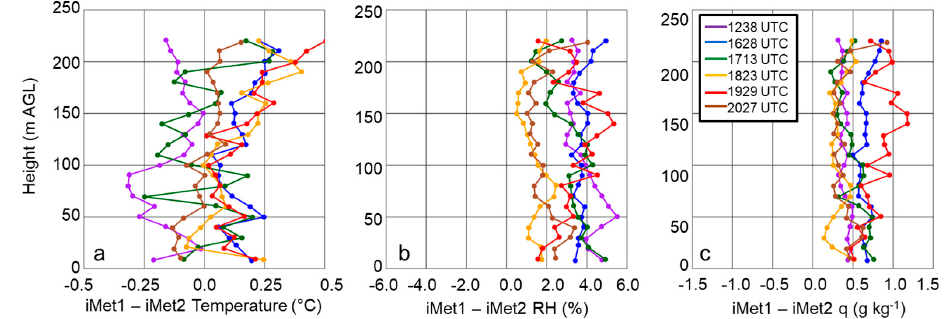
Figure 6. Difference between two iMet-XQ sensors; iMet-XQ 1 and iMet-XQ 2, in temperature ( a ), RH ( b ), and q ( c ) during six flights using a DJI S-1000 sUAS flown on 5 April 2017 at Cullman, AL. Purple, blue, green, orange, red, and brown correspond with flights made from 1238-1244 UTC, 1628-1639 UTC, 1713-1725 UTC, 1823-1834 UTC, 1929-1940 UTC, and 2027-2037 UTC, respectively. Data were averaged into 10-m bins.